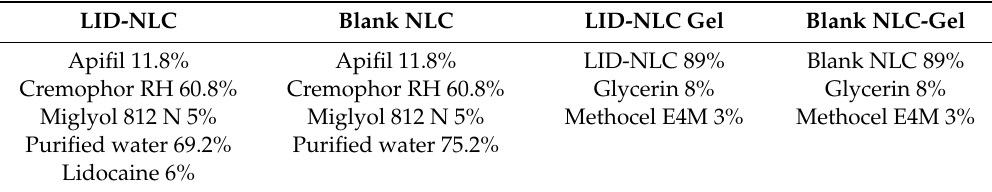
Table 1. Compositions of the test